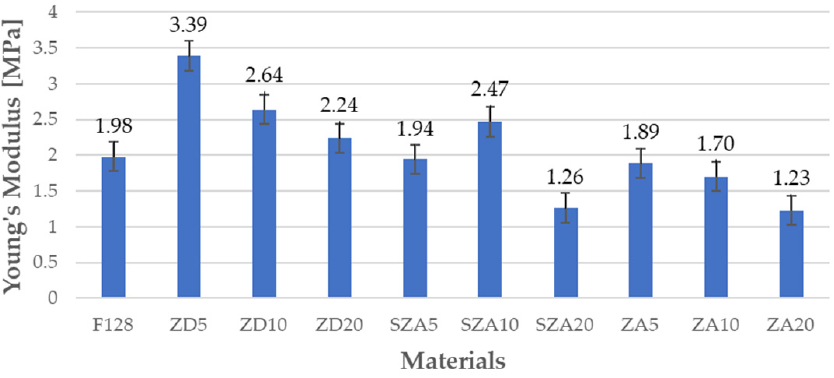
Figure 5. Young’s moduli of the tested materials. Young’s modulus of the silicone matrix was 1.98 MPa. For samples filled with zinc dust in the tested concentration range, Young’s modulus was higher than that for silicone F128; however, as the dust concentrations in the composite increased, the Young’s modu- lus values decreased (ZD5—3.39 MPa, ZD10—2.64 MPa, and ZD20—2.24 MPa). Materials with zinc ash as a filler had a lower Young’s modulus than F128; however, a trend could be observed: upon increasing the amount of filler, Young’s modulus decreased (ZA5— 1.89 MPa, ZA10—1.7 MPa, and ZA20—1.23 MPa). For materials using zinc ash as the filler, the samples with 10% filler showed higher Young’s moduli than the samples with 5% filler. For samples with 20% filler, Young’s modulus decreased to a level similar to that of ZA20 (1.26 MPa). Compared with F128, the decrease in both materials was approximately 35%.